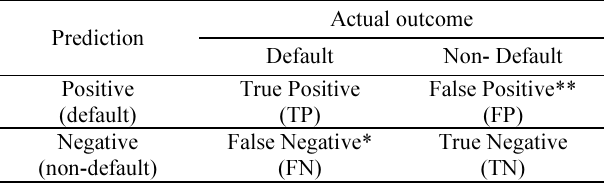
Table 1. The fractions of ROC curve